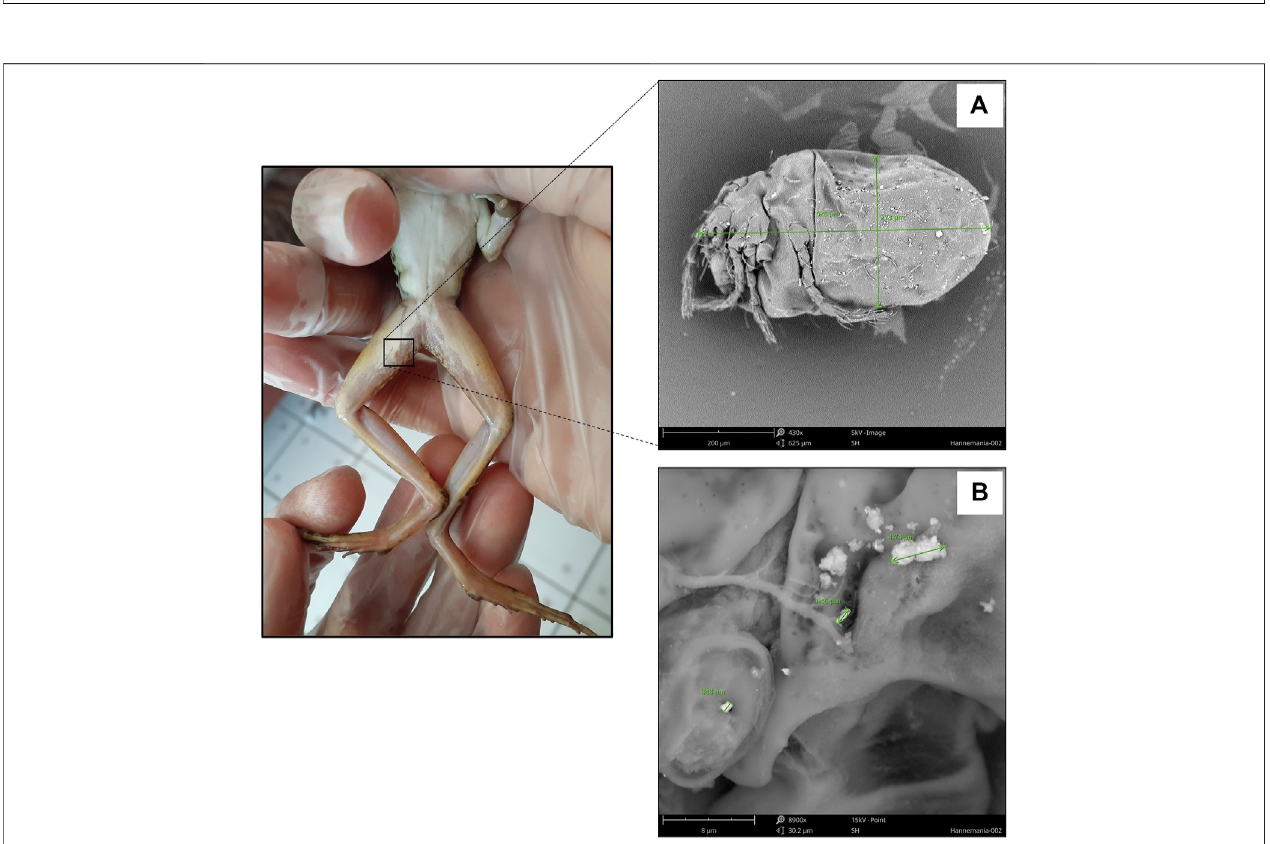
FIGURE 4 | Lithobates yavapaiensis parasitized by Hannemania mites (A) Backscattered electron micrographs of a Hannemania mite, and (B) ultra fi ne particles containing Ce, Sb, and Zr, among other traf fi c-related elements.